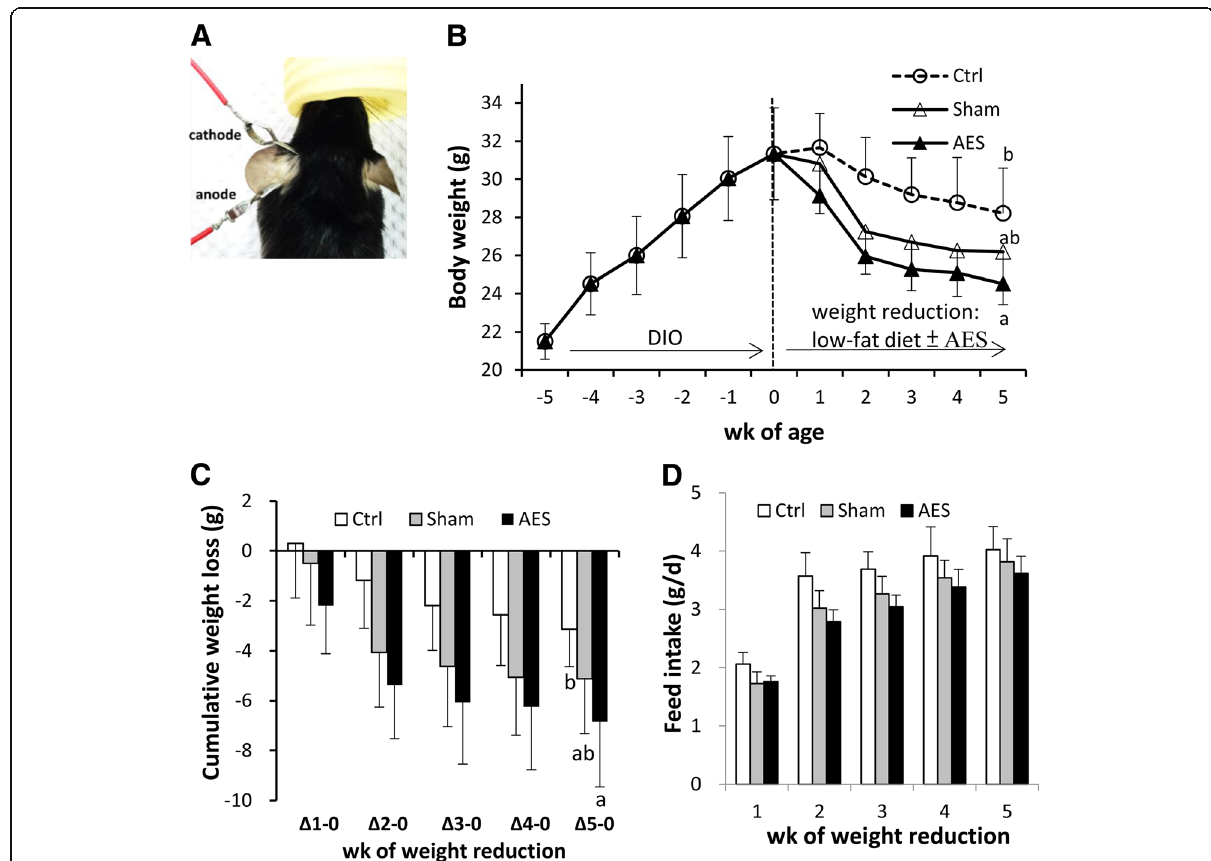
Fig. 1 Application of clip electrodes on mouse ears ( a ), body weight throughout the study ( b ), as well as cumulative weight loss ( c ) and daily feed intake ( d ) during low-fat diet intervention period of mice in three groups. Data are mean ± SD, n = 8. a,b Means without a common letter differed ( P < 0.05)